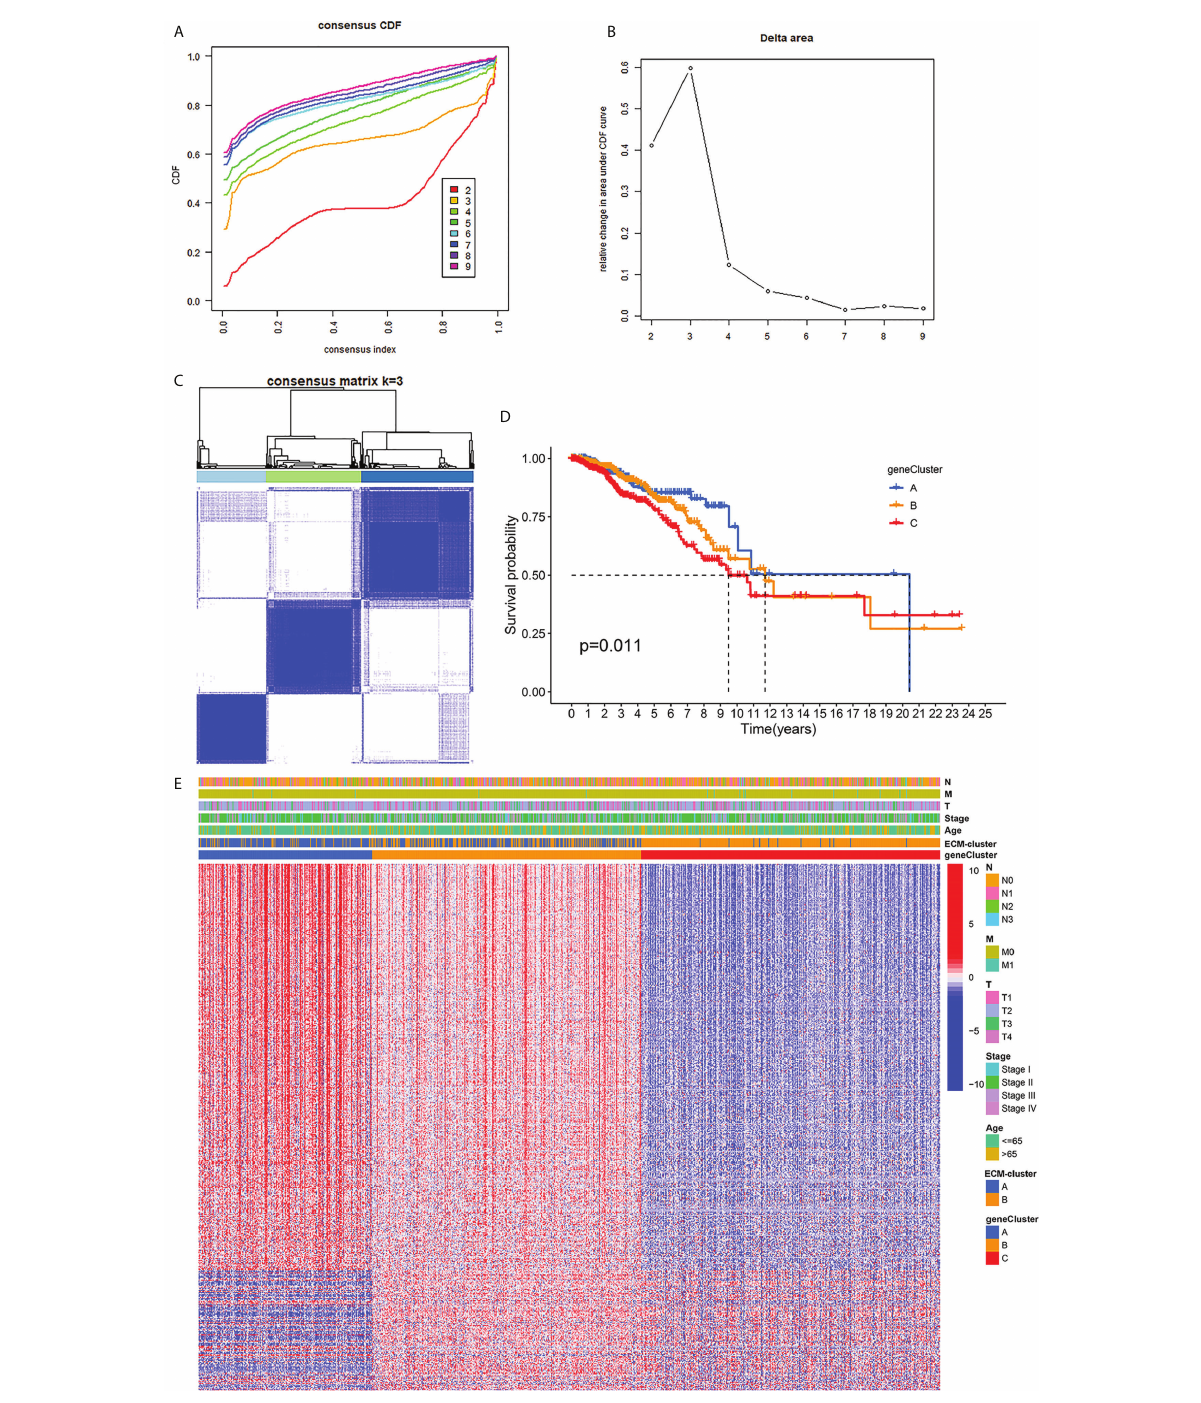
FIGURE 4 Classi fi cation of breast cancer patients into three gene-clusters based on DEGs between ECM-clusters. (A) The CDF curves obtained by consensus clustering based on the DEGs between ECM-clusters. (B) The function delta area under CDF curves. (C) Classi fi cation of breast cancer patients into three gene-clusters according to consensus clustering with k=3. (D) Kaplan-Meier survival analysis demonstrated the prognostic differences between these three gene-clusters. (E) The heatmap demonstrated the overview of DEGs in the ECM-clusters and gene- clusters. DEGs, differential expressed genes; CDF, cumulative distribution